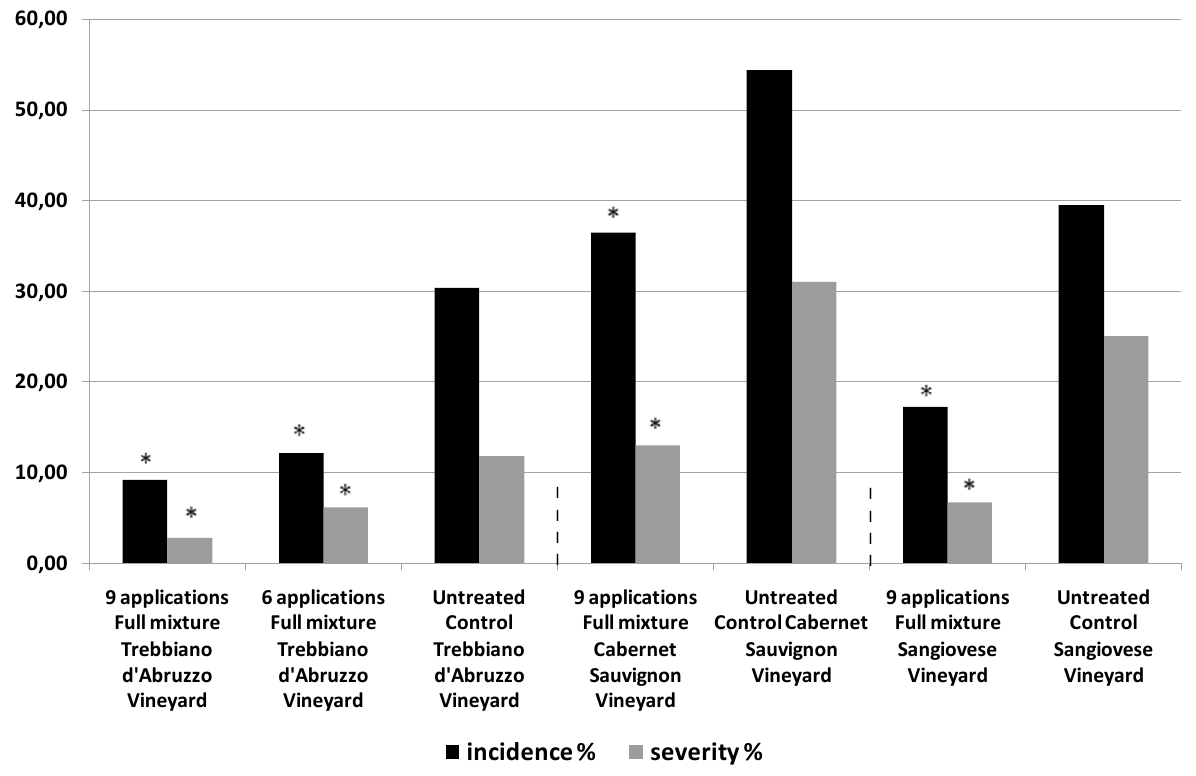
Figure 2. Mean incidence and severity of GLSD leaf symptoms in Trebbiano d’Abruzzo, Cabernet Sauvignon and San- giovese vineyards after applications of the mixture of CaCL 2 , Mg(NO 3 ) 2 and seaweed extract in 2014. Chi-square statistics compared the full mixture treatments to the untreated controls in three trials. In the Trebbiano d’Abruzzo vineyard the nine applications treatment was also statistically compared with the six applications treatment. For symptom incidence or severity, * indicates statistically significant differences ( P < 0.05) between treatments. Bars labeled with the same symbol are not statistically